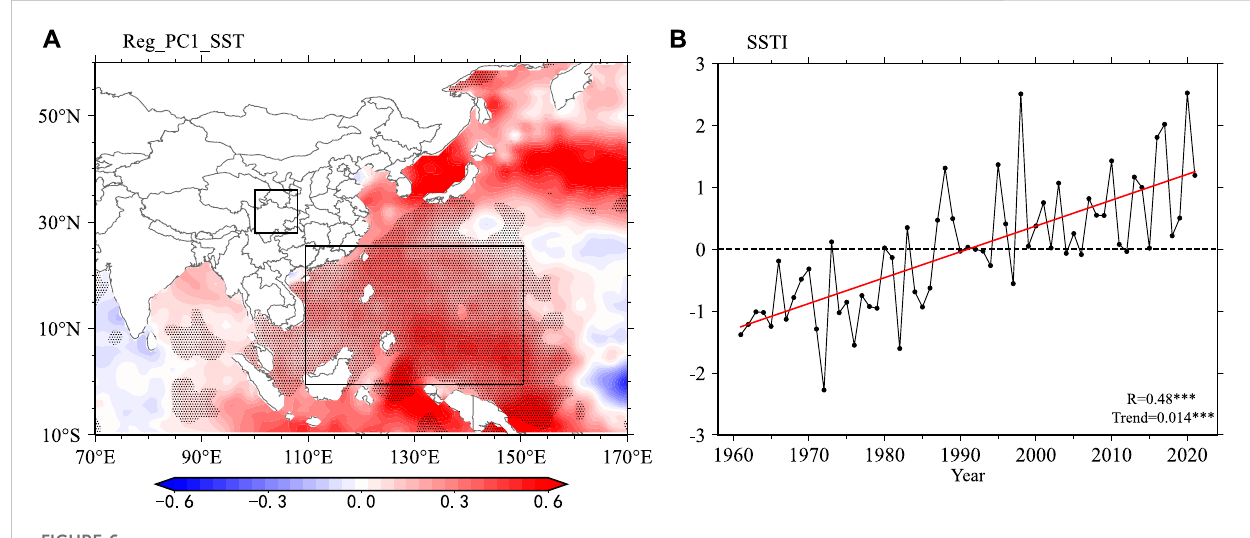
FIGURE 6 (A) Regressed SST maps in summer onto the interannual component of PC1 from 1961 to 2021, and (B) the standardized SSTI series and its linear trend during 1961 – 2021. The two black rectangular frames in (A) represent locations of WC and pass the 95% signi fi cance level, respectively. The black rectangular boxes in (A) represent locations of WC and pass the 95% signi fi cance level,